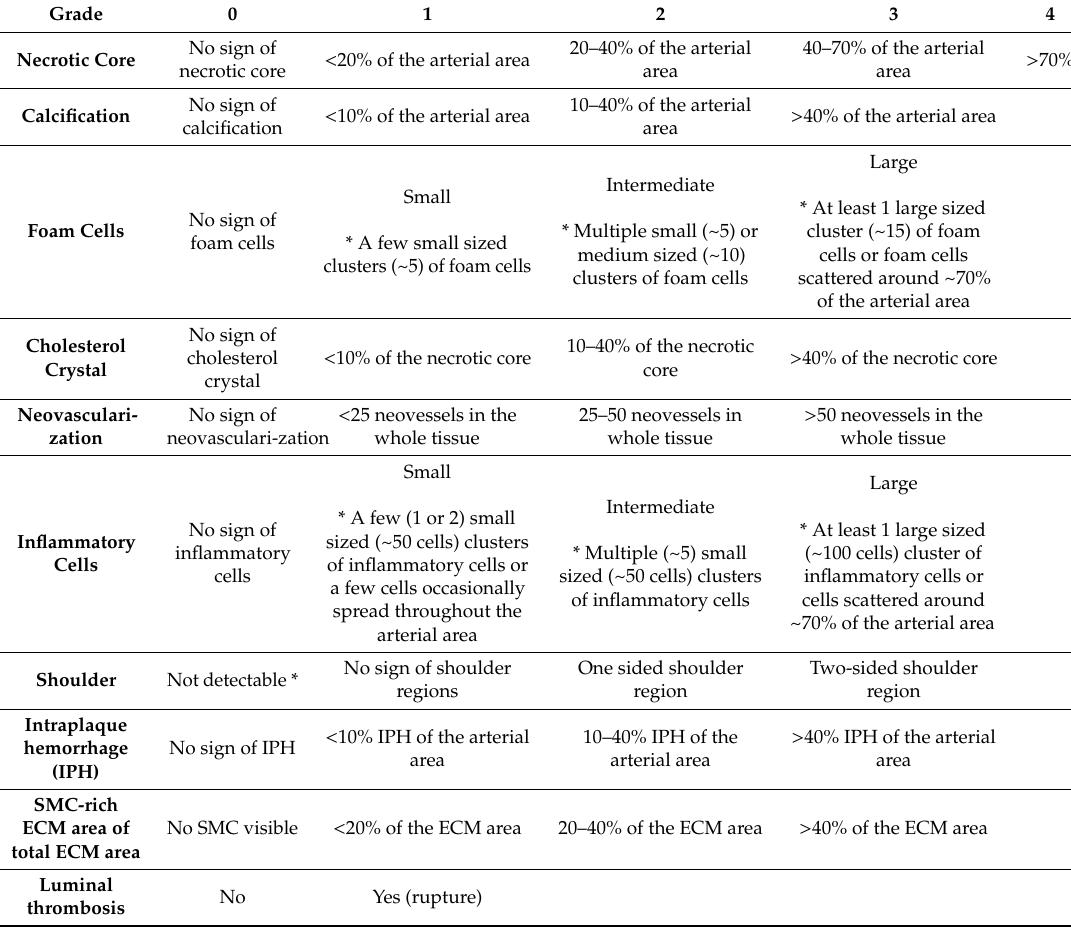
Table 1. Semiquantitative grading scale for the histology score of human endarterectomy